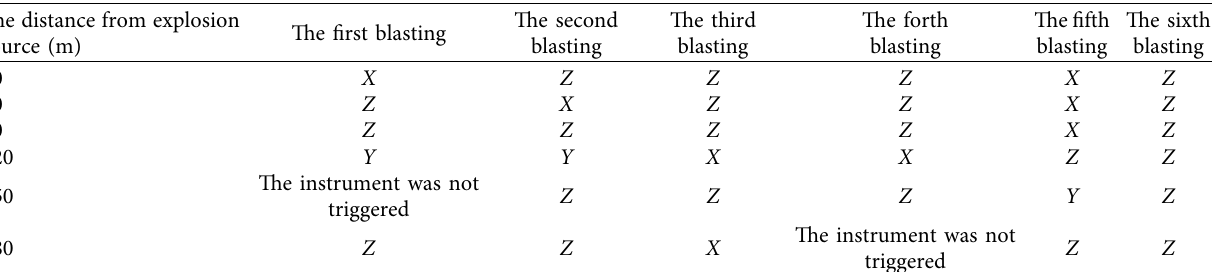
Table 6: Directions of the maximum